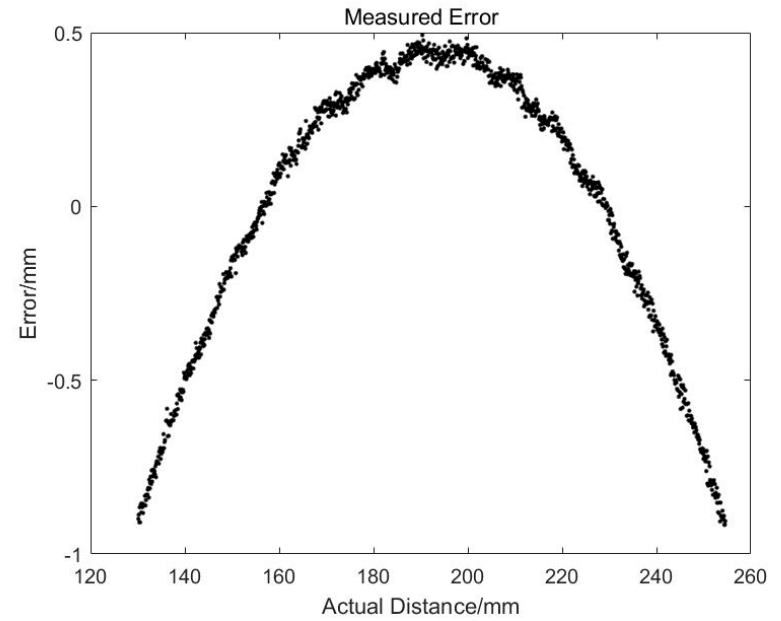
Figure 8. Errors of the online measurement system.